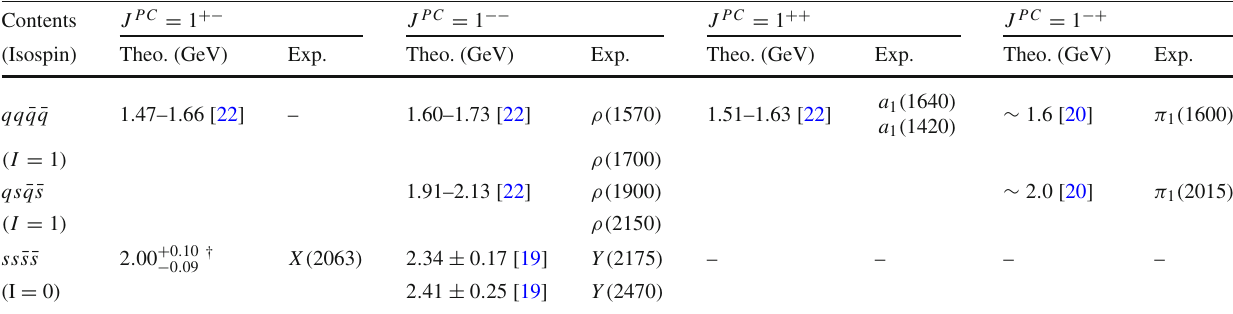
GeV denoted by † is obtained in the present 0 . 09